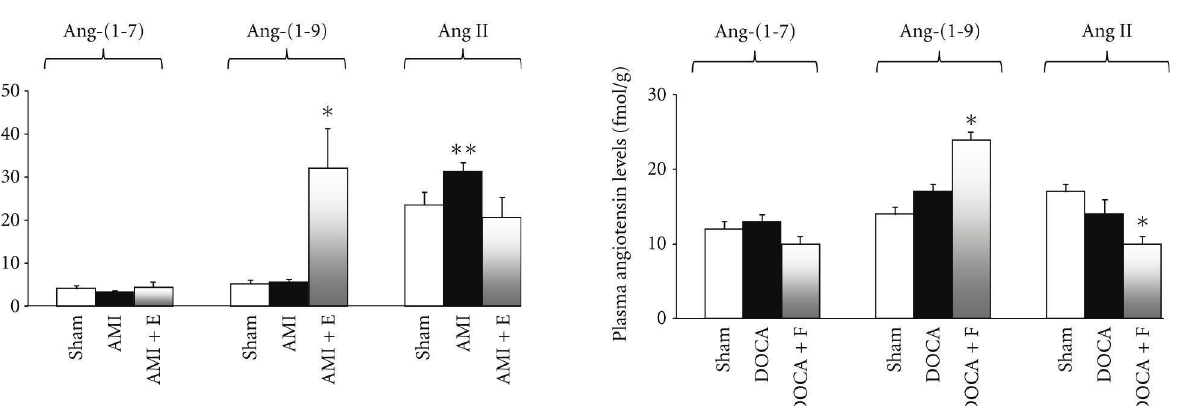
Figure 1: Plasma levels of Ang-(1–7), Ang-(1–9) and Ang II in rats with myocardial infarction treated with the ACE inhibitor enalapril (8 weeks). Increased plasma levels of Ang-(1–9) were observed in rats with myocardial infarction treated with the ACE inhibitor enalapril. Myocardial infarction was induced by coronary artery ligation. Data are presented as mean ± SEM ( n = 12/group). AMI: acute myocardial infarction, E: enalapril. ∗ P < 0 . 05 compared to both Sham and untreated myocardial infarction groups; ∗∗ P < 0 . 05 compared to both Sham and enalapril-treated myocardial infarction groups. (adapted with permission from [51]).